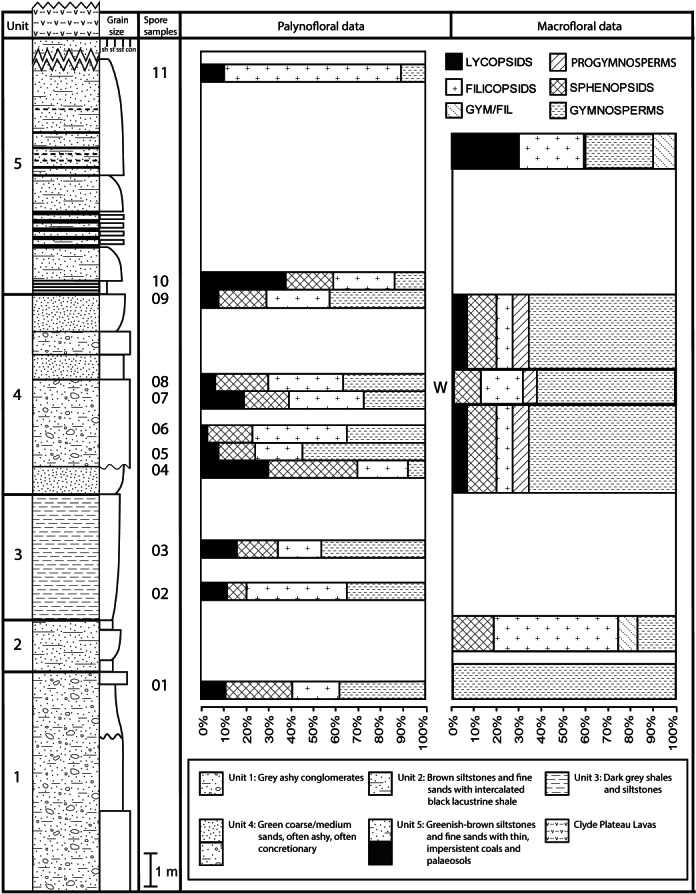
Histograms of the relative proportions of land-plant microfossils (left) and macrofossils (right) in different taxonomic classes.Plotted against a simplified sedimentary log of the Loch Humphrey Burn sequence. Some organ-genera of fern-like foliage cannot be apportioned between ferns and seed-ferns, hence the use of a pteridosperm/fern (‘Gym/Fil’) category in the macrofossil histogram. The well-known Walton Bed is marked W.